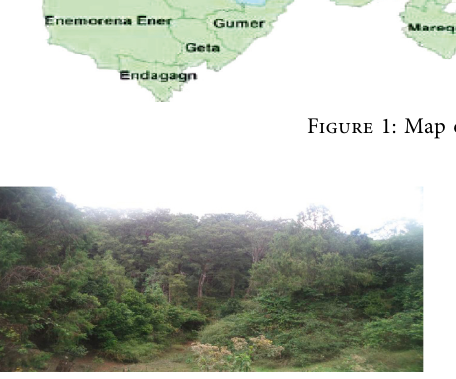
Figure 2: Amba forest (study area) (photo by